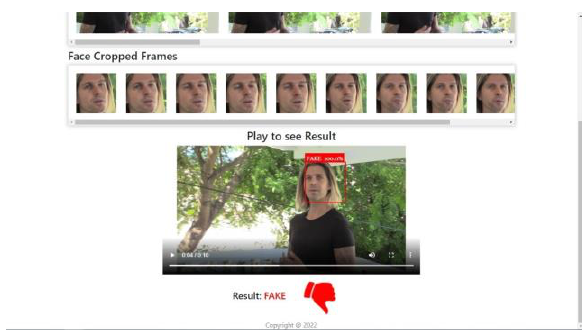
Fig. 8. Detection of Real Video